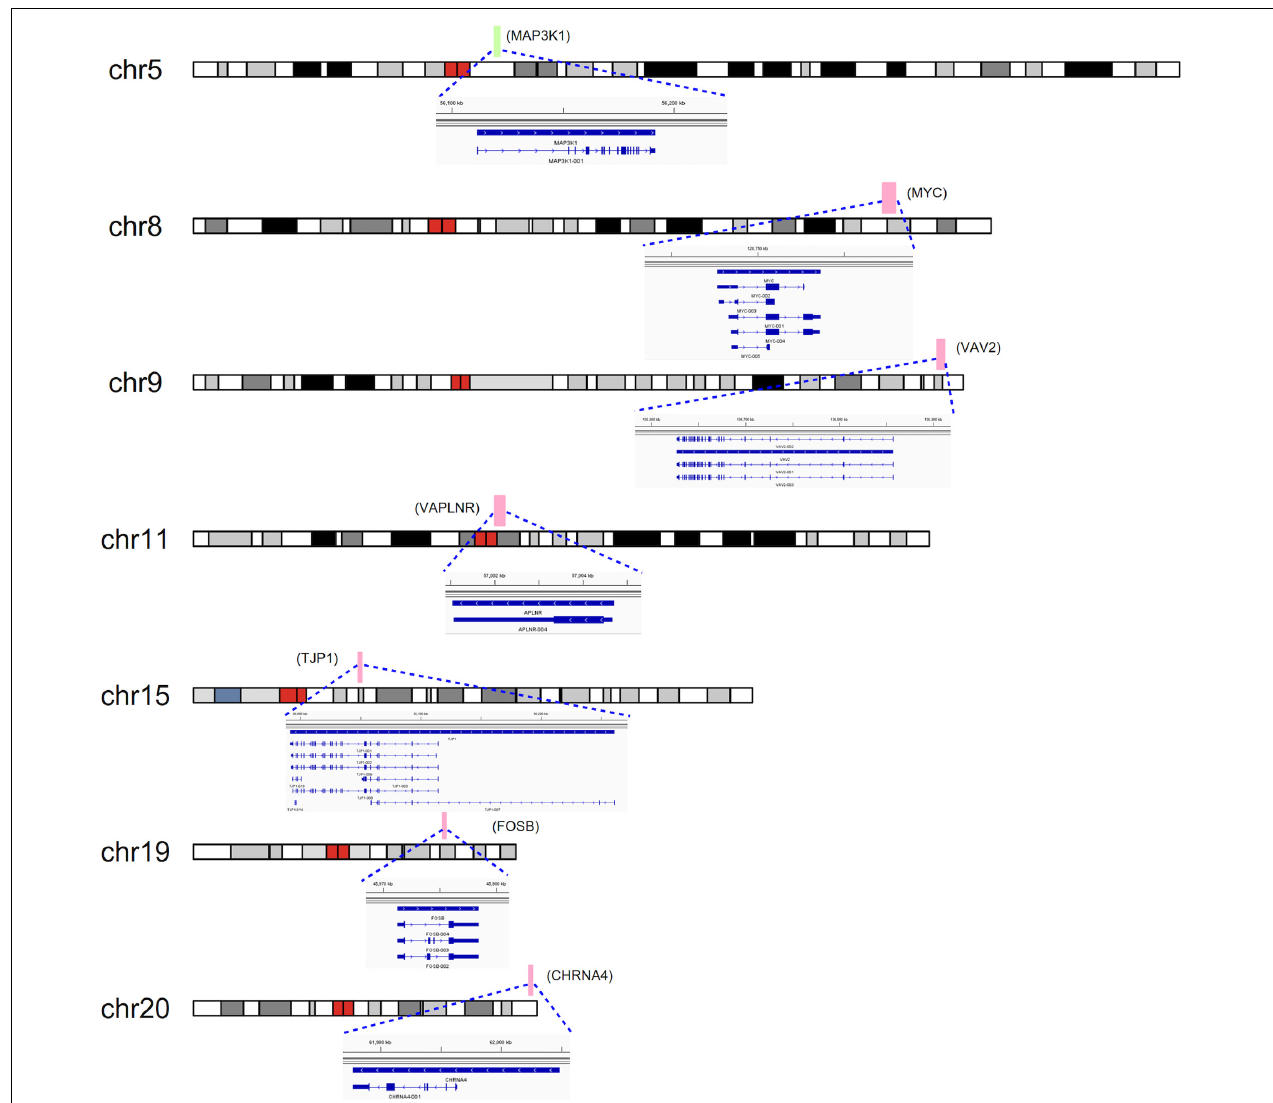
FIGURE 7 | CNVs were analyzed with respect to their structural and genomic characteristics including span, and chromosomal location. Rare CNVs overlapping novel candidate gene for PDA: MAP3K1, MYC, VAV2, APLNR, TJP1, FOSB, and CHRNA4. The dotted rectangles represent the location of genes.